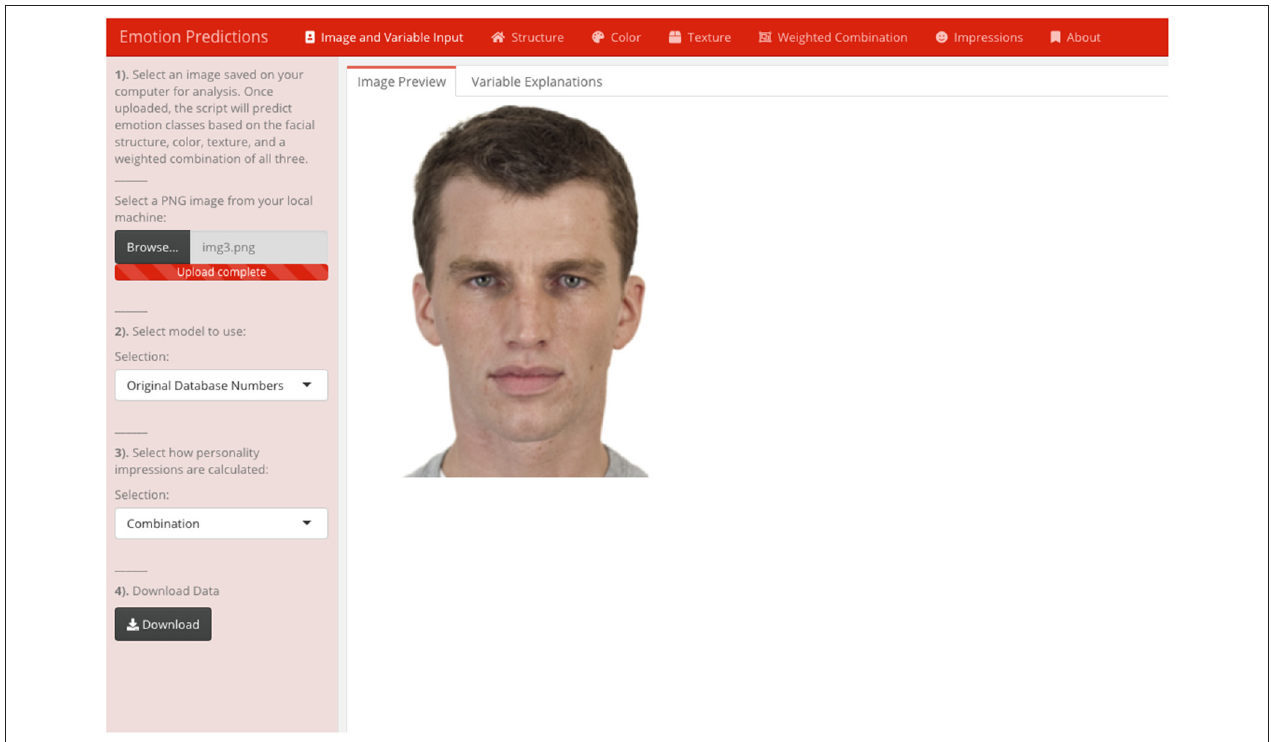
FIGURE 6 | Image of GUI designed to predict the emotion expression and impressions of an uploaded face image. End-users have access to each feature model (structure, color, and texture), the weighted model of all three features, and algorithmically computed impressions for the uploaded face image (see panel at top of the